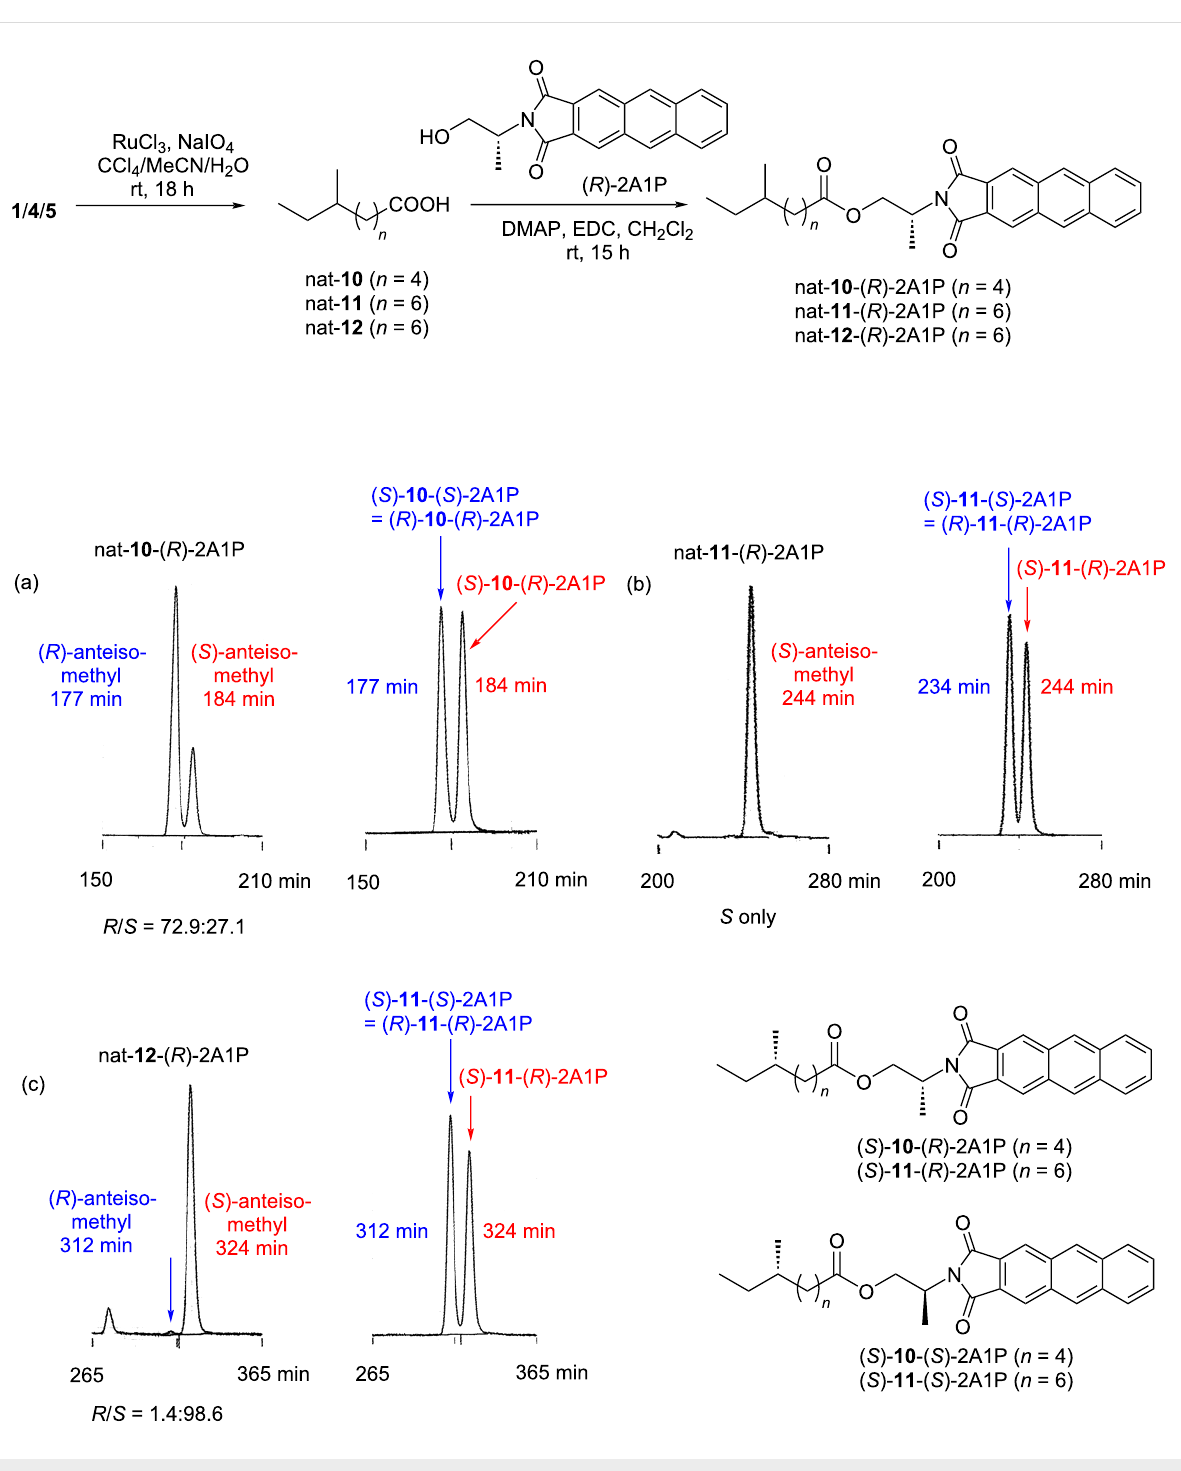
Figure 4: Determination of the absolute configuration of 1 (a), 4 (b), and 5 (c) by the Ohrui–Akasaka